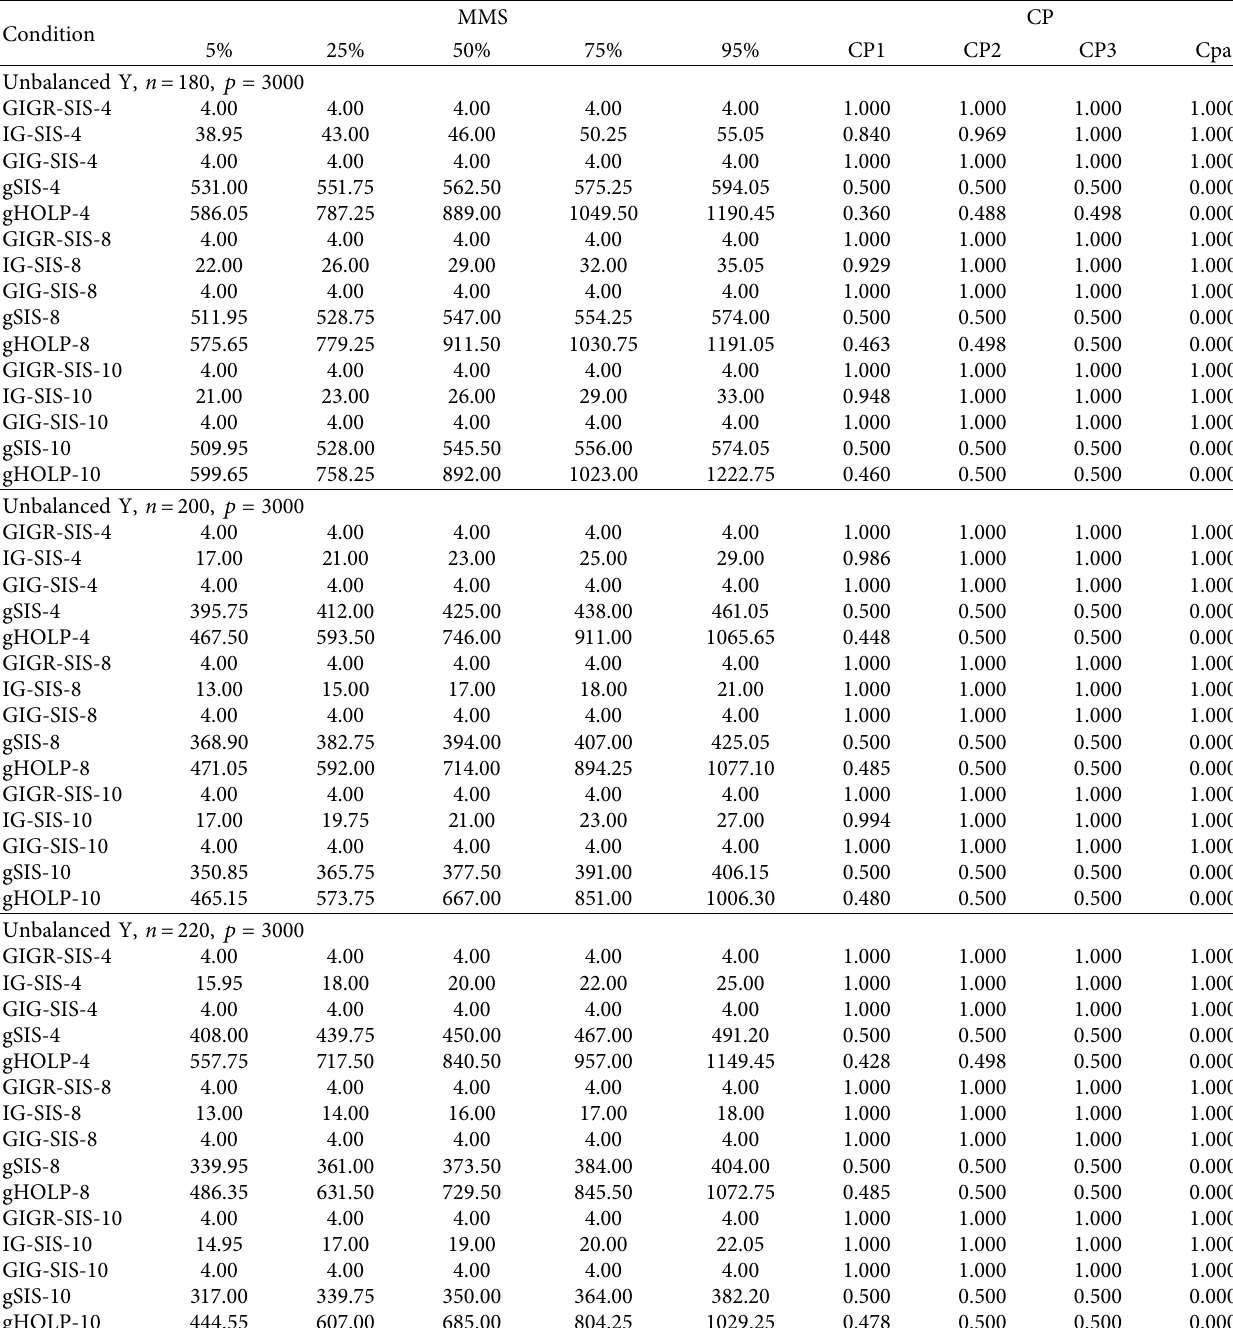
Table 5: Simulation results for Model 3: unbalanced